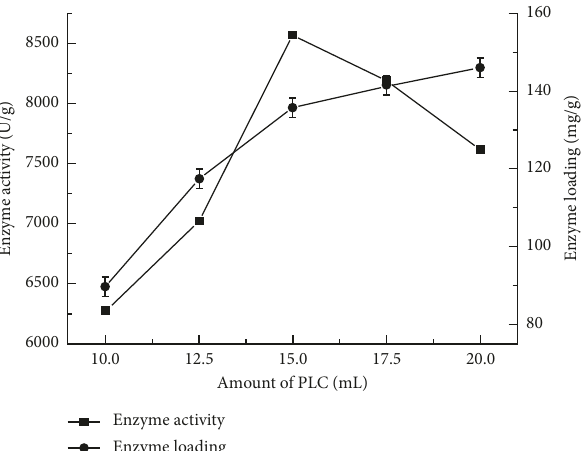
Figure 1: Effect of free PLC dosage on enzyme loading and enzyme activity. The reaction conditions were as follows: reaction temperature 55 ° C, pH 7.0, and reaction time 5h. The optimum enzyme dosage was 15mL, the enzyme loading of Fe 3 O 4 @SiO 2 @p(GMA) was 135.64mg/ g, and the enzyme activity of PLC-Fe 3 O 4 @SiO 2 @p(GMA) was